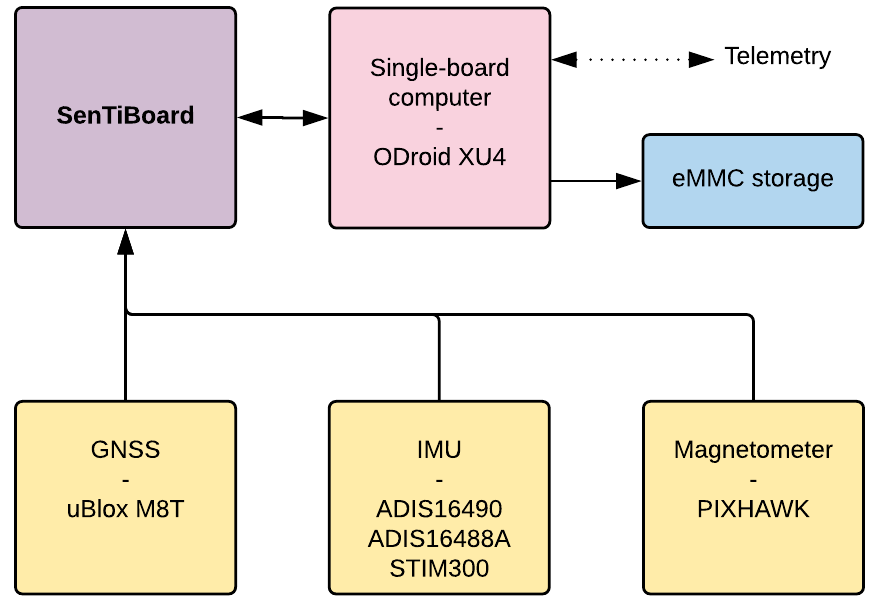
Figure 10. Overview of the components of the SenTiStack. In each of the sensor boxes (yellow), one or more of the options can be chosen, depending on the specific mission requirements. The telemetry link is optional, but can provide useful data about the system status, current sensor measurements, and provide data for RTK-GNSS